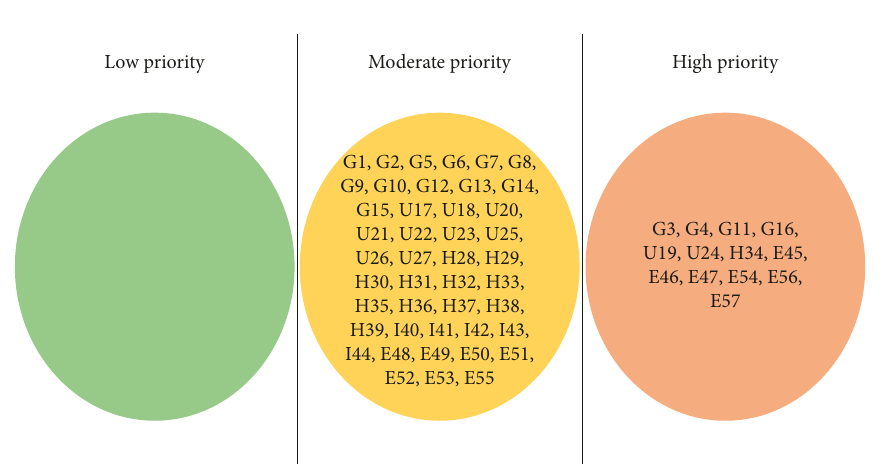
Figure 3: Sorting of the roles of various